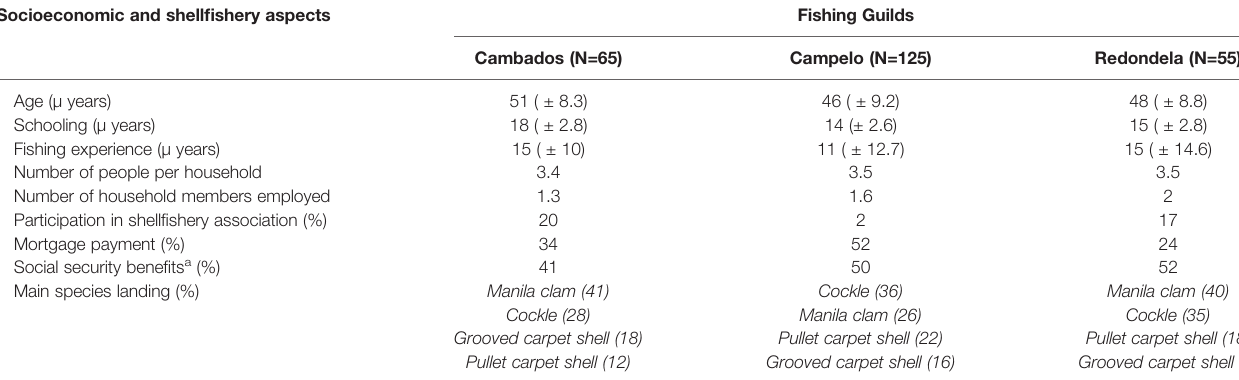
TABLE 3 | Socioeconomic and fi shery aspects of shell fi sheries in three study areas in Galicia: Cambados, Campelo, and Redondela. N, number of fi shers; µ, Mean; ±, standard deviation. Main species landing = percentage of landing species (on foot + on boat). Socioeconomic and shell fi shery aspects